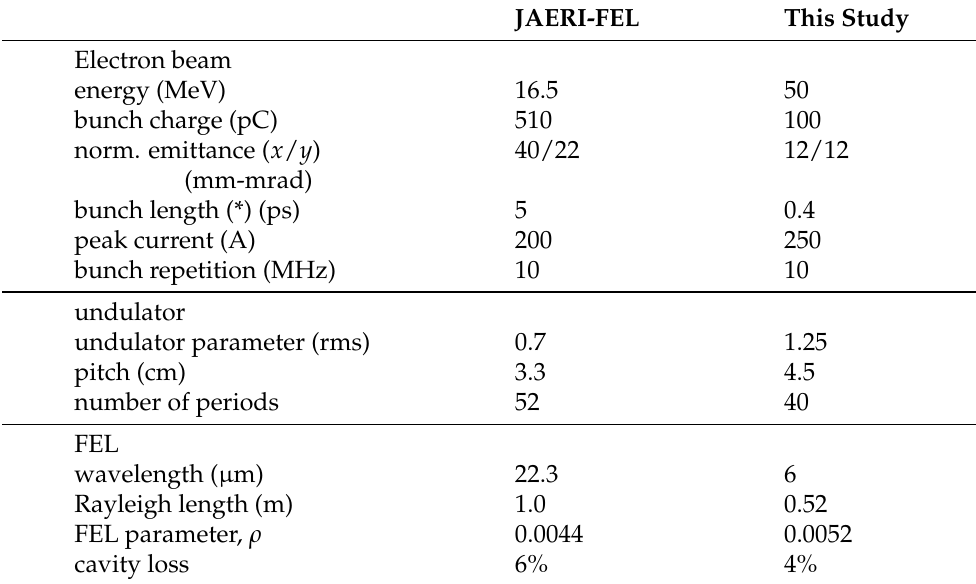
Table 1. Parameters for the JAERI-FEL experiment and simulation presented in Figures 10 and